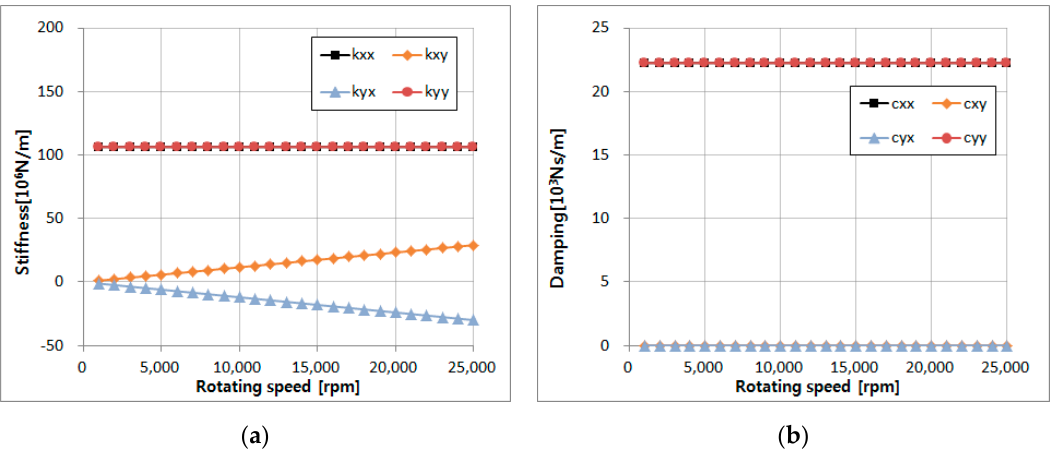
Figure 8. Stiffness and damping versus rotor speed. ( a ) Stiffness; ( b ) Damping.